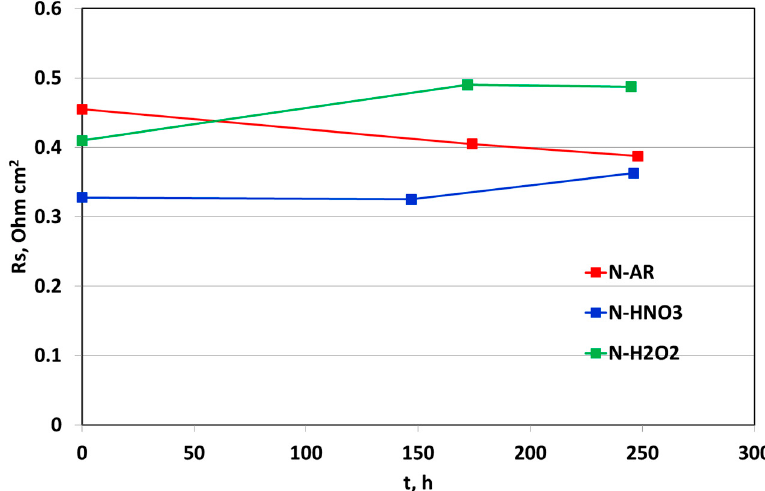
Figure 10. Trend of Rs measured from EIS as a function of time for N-AR (red squares), N-HNO3 (blue squares) and N-H2O2 (green squares) membranes.